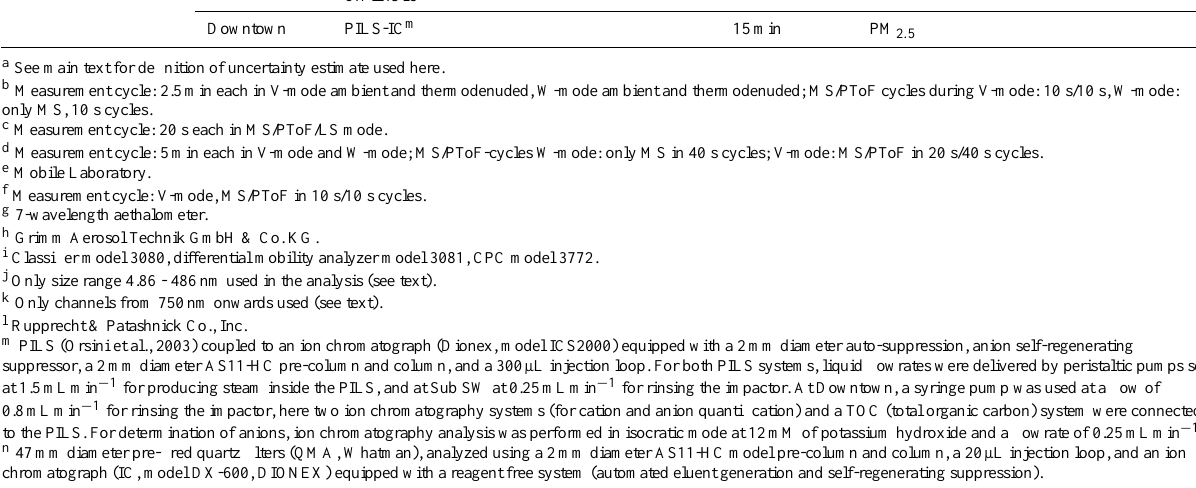
Table 1. Instrumentation for measurement of the particle phase used in this study. Parameter(s) Site Instrument Model (manufacturer) Time resolution Size range Uncertainty estimate Sub SW HR-ToF-AMS (Aerodyne Research, Particulate organics, nitrate, sulphate,